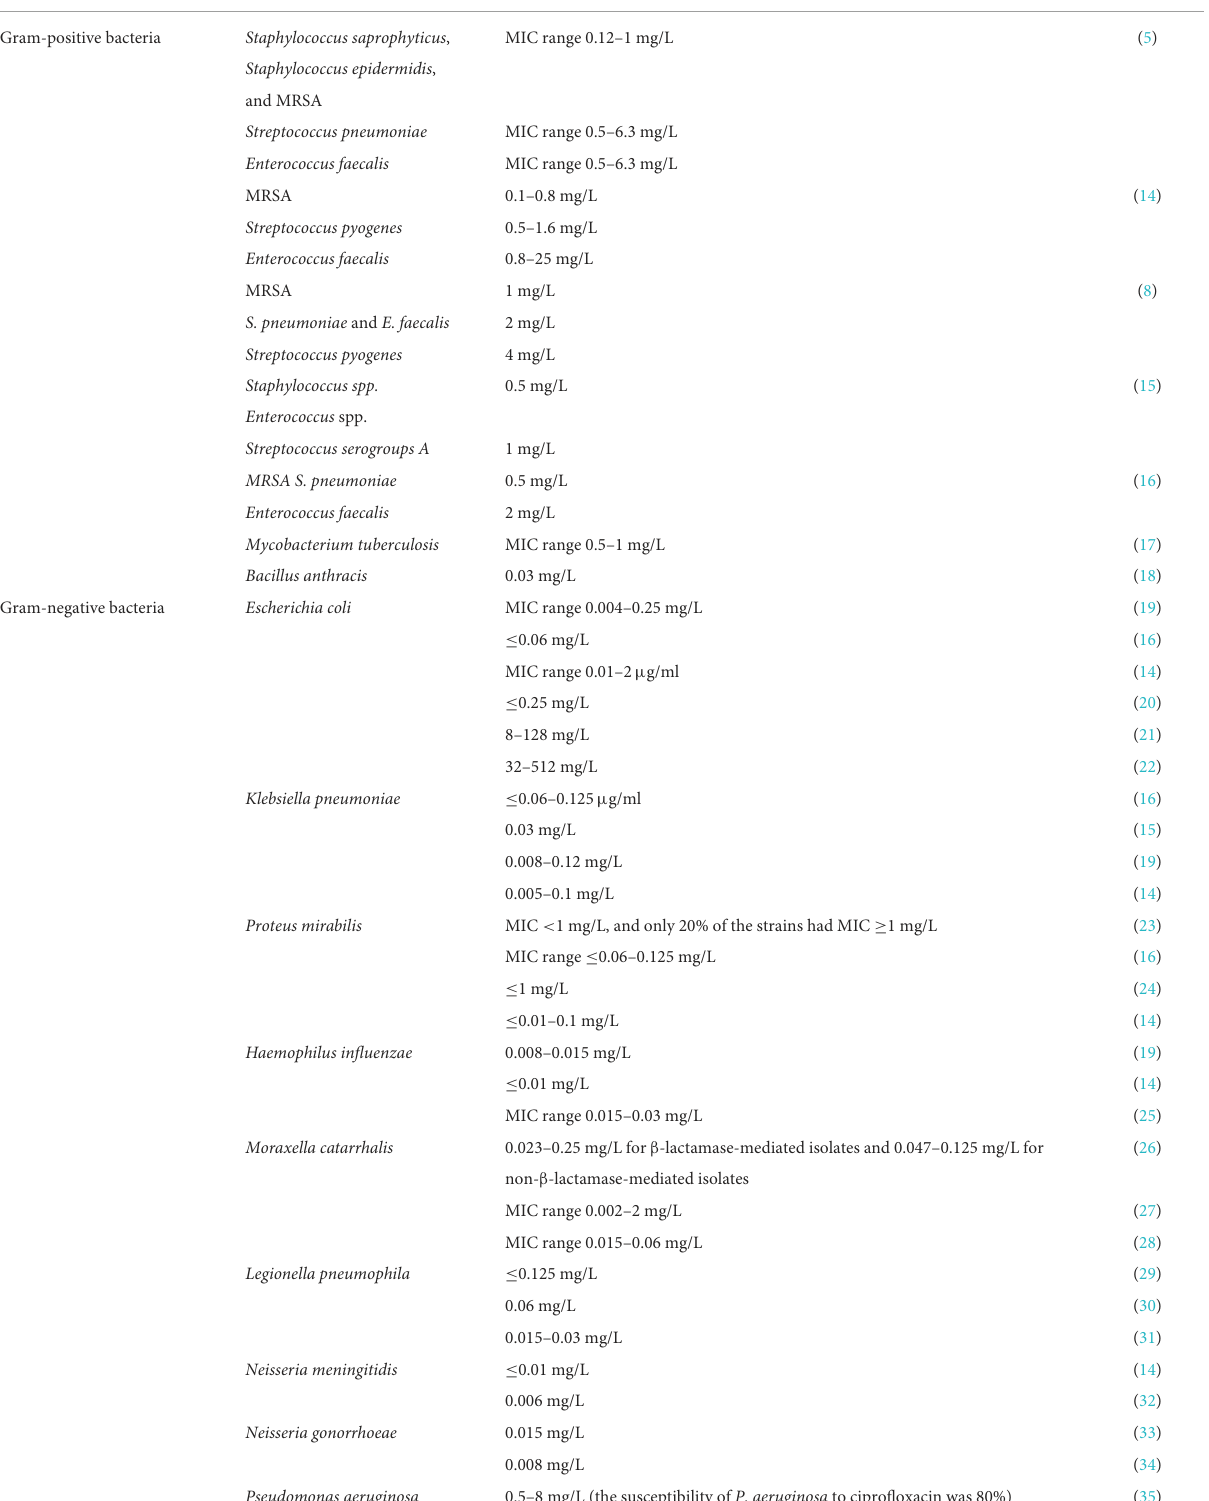
TABLE 1 The inhibitory effect of ciprofloxacin against various Gram-positive and Gram-negative bacteria.